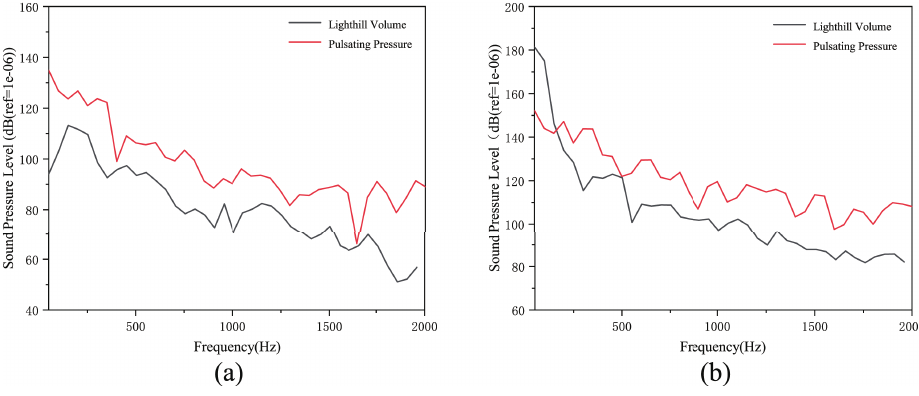
Figure 9. Comparison results of spectral characteristics. ( a ) Receiver 1 ( b ) Receiver